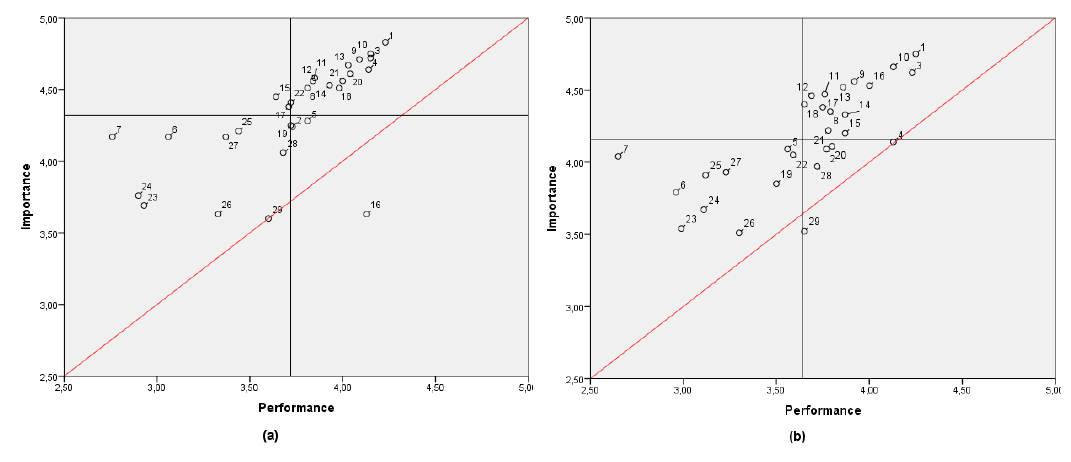
Figure 3. IPA matrix comparison by gender: ( a ) women; ( b ) men. Table 3. Gender correlation with importance and performance